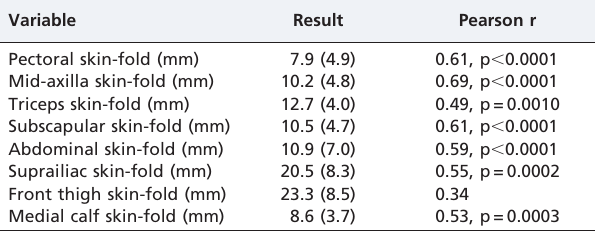
Table 2 - Association of skin-fold thicknesses with race time (n= 42).